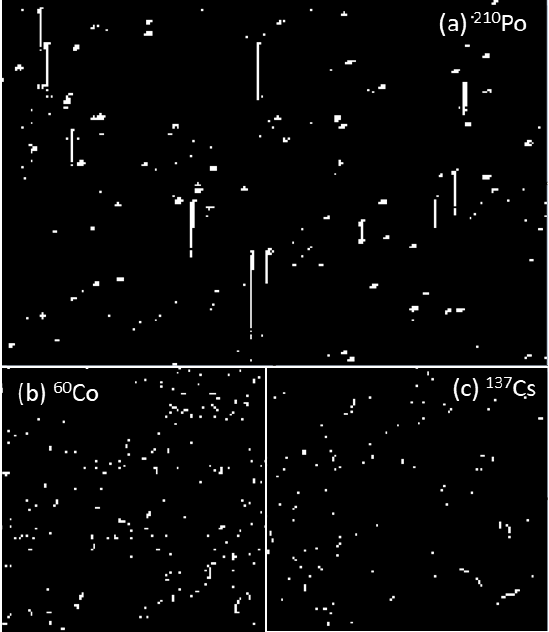
Fig. 2. Example sections of typical exposures to: (a) a 210 Po (cid:3)(cid:68) -particle source for 30 s; (b) a 60 (cid:38)(cid:82)(cid:3)(cid:533)(cid:18)(cid:534)(cid:3)(cid:86)(cid:82)(cid:88)(cid:85)(cid:70)(cid:72)(cid:3)(cid:73)(cid:82)(cid:85)(cid:3)(cid:24) s; (c) a 137 (cid:38)(cid:86)(cid:3)(cid:533)(cid:18)(cid:534)(cid:3)source for 1 s.